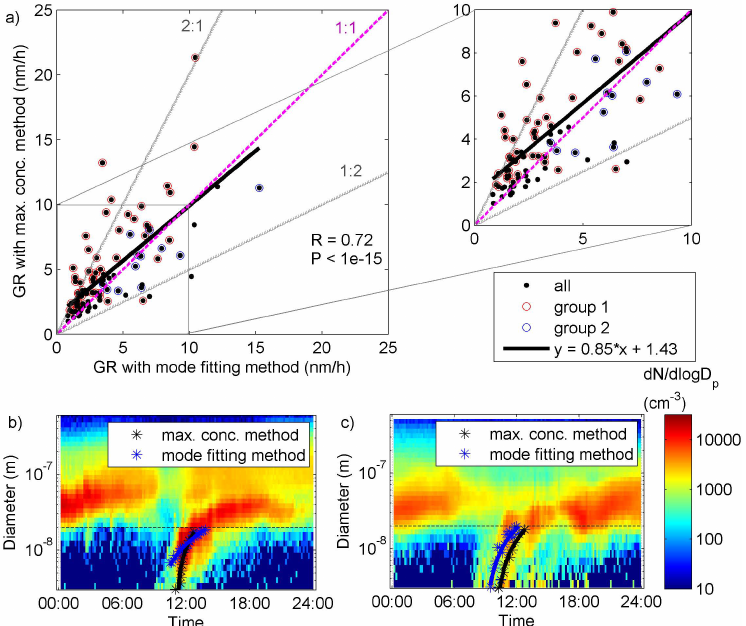
Fig. 6. (a) Comparison of the growth rates calculated applying the maximum concentration method (y-axis) to growth rate calculated with mode fitting method (x-axis) from DMPS data for the size range of 3–20nm. Also shown are the straight line fitted to the data and the correlation coefficient and p-value between the growth rates calculated with the two methods. The dashed line is the 1:1 line and the dotted lines represent the factor of two difference in the growth rates. Examples of the (b) Group 1 (large initial size in mode fitting method) and (c) Group 2 (small initial size in mode fitting method) events with the points showing the representative sizes of the nucleation mode found with the two GR calculation methods as a function of time and the lines corresponding to the fitted straight lines in linear diameter scale. The size distributions are measured with DMPS and the color indicates the